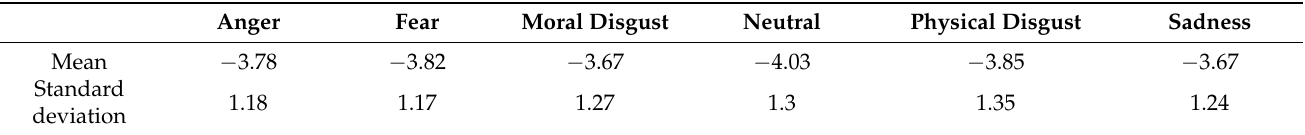
Table 3. Means and standard deviation of individual discount rates (log k) across the six experimental conditions (Exper- iment 1).